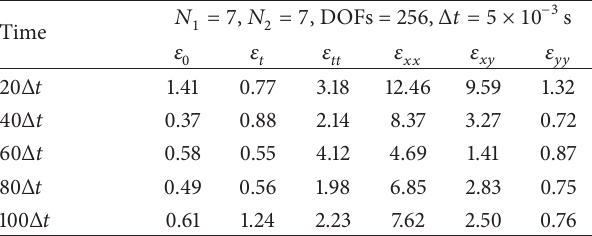
Table 6: Global errors of the finite method with Cubic B-spline